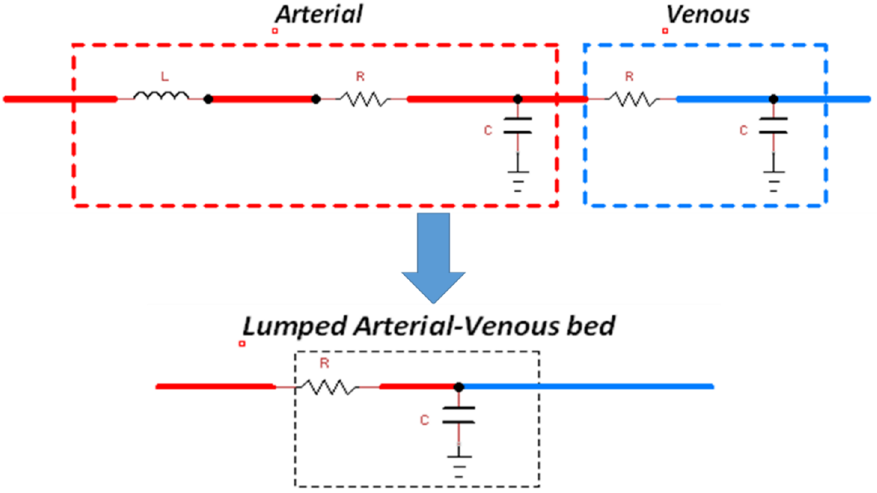
Figure 2 . Lumped Arterial and Venous bed coupled for LPM development to conduct in-vitro studies.